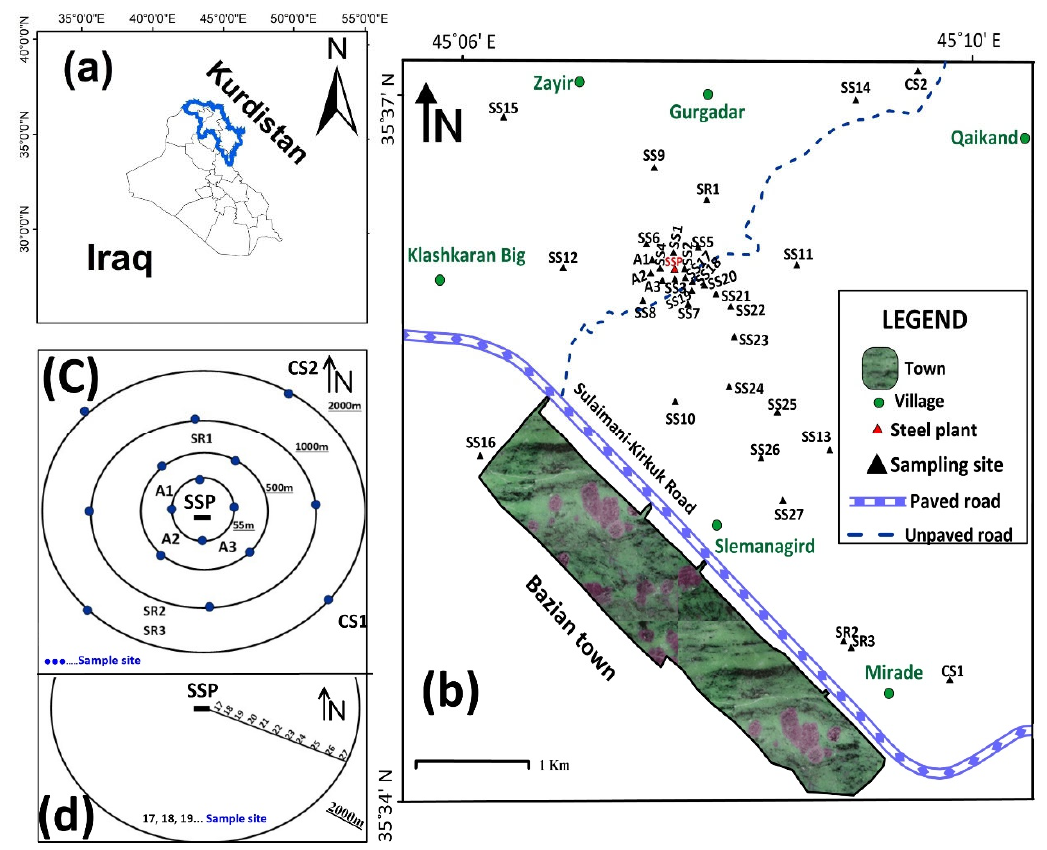
Figure 1. ( a ) Location of Kurdistan Region in Iraq, ( b ) location map of the studied samples, ( c ) sampling sites at different distances from the Sulaimani Steel Plant (SSP), ( d ) sampling sites downwind from the SSP to a distance of 2000 m in the direction of SE.